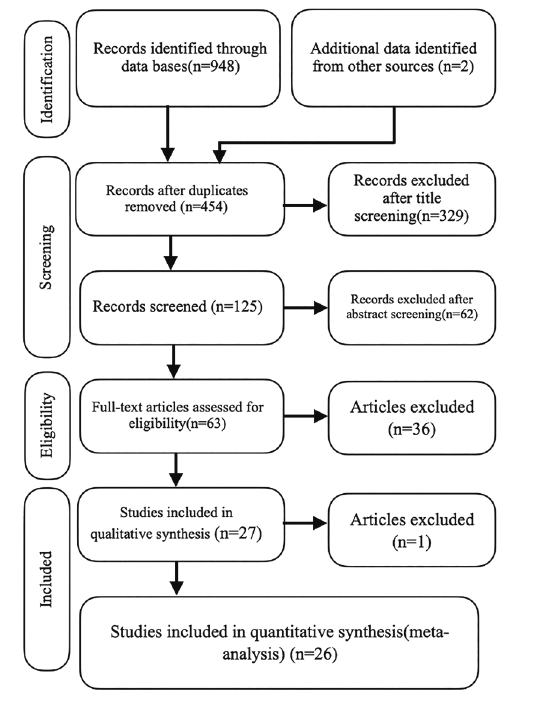
Figure 1 - Flow diagram of the study search and